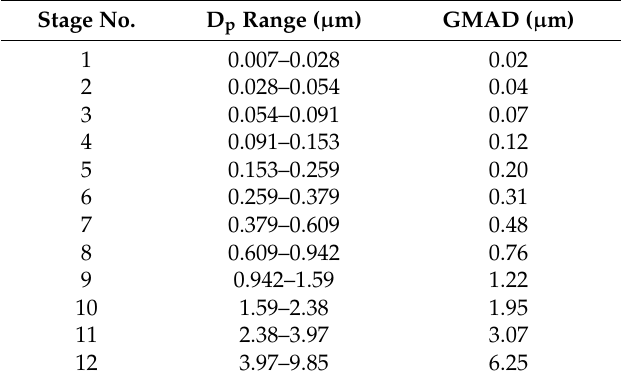
Table 1. Aerodynamic diameter intervals and geometric mean aerodynamic diameters. Stage